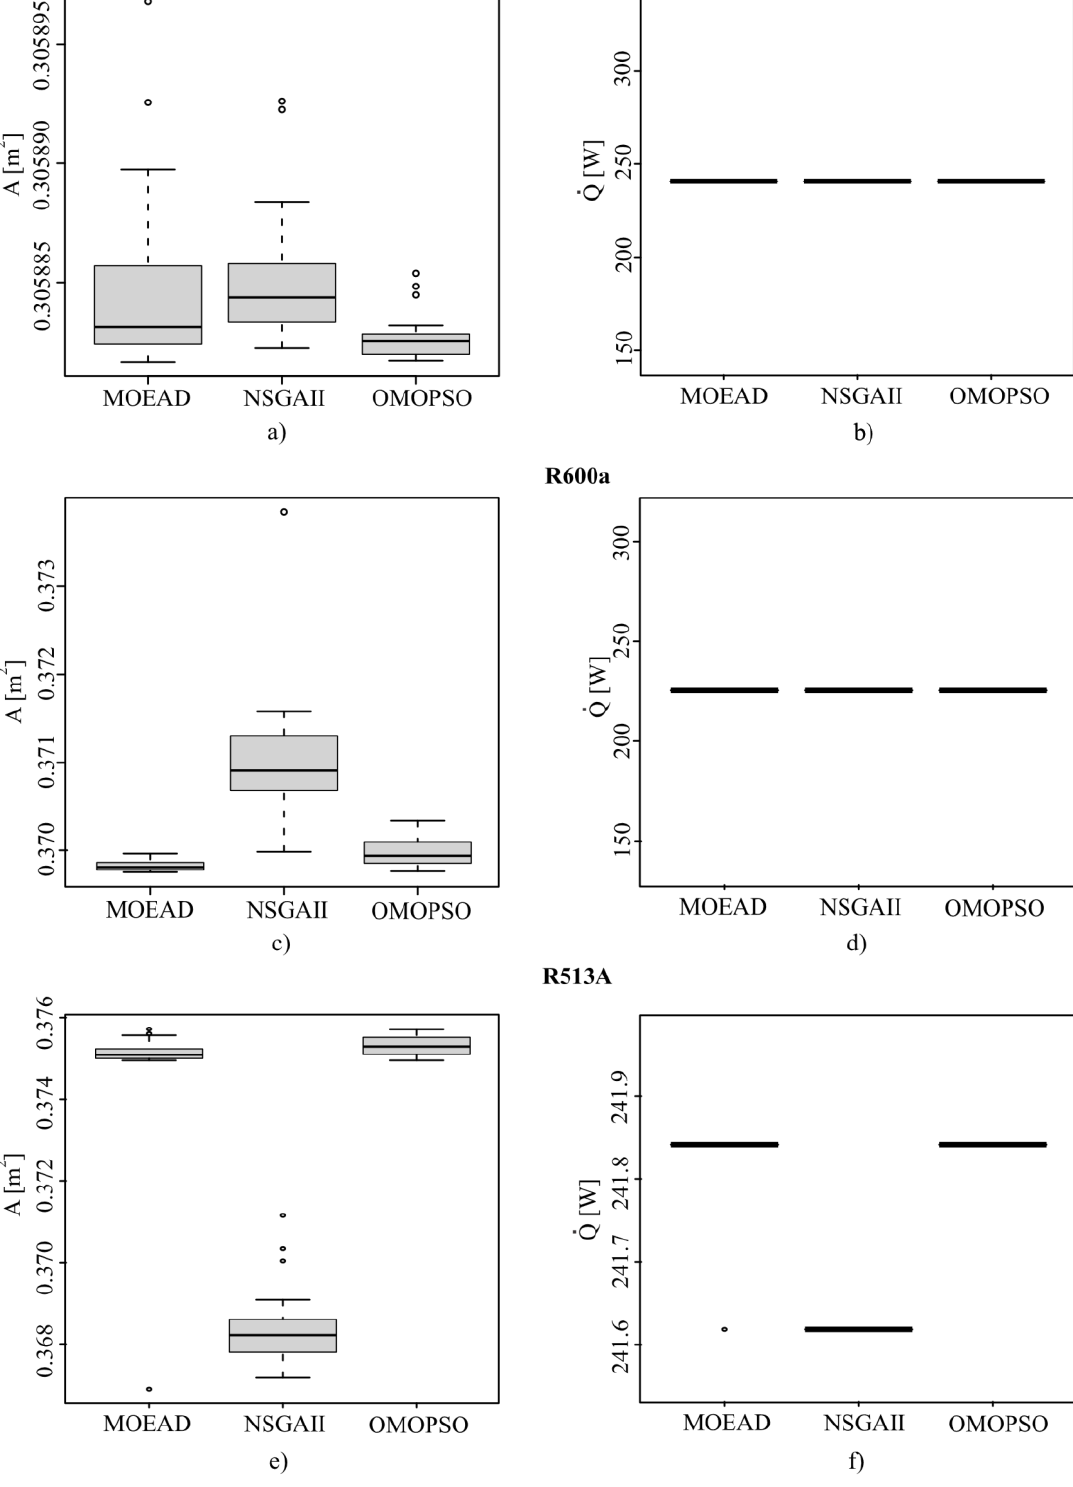
Figure 3. Statistical comparison between NSGAII, OMOPSO, and MOEAD algorithms. ( a , c , e ) heat transfer area; ( b , d , f ) heat transfer.